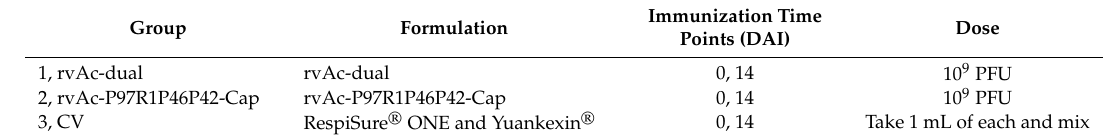
Table 3. Piglet vaccination